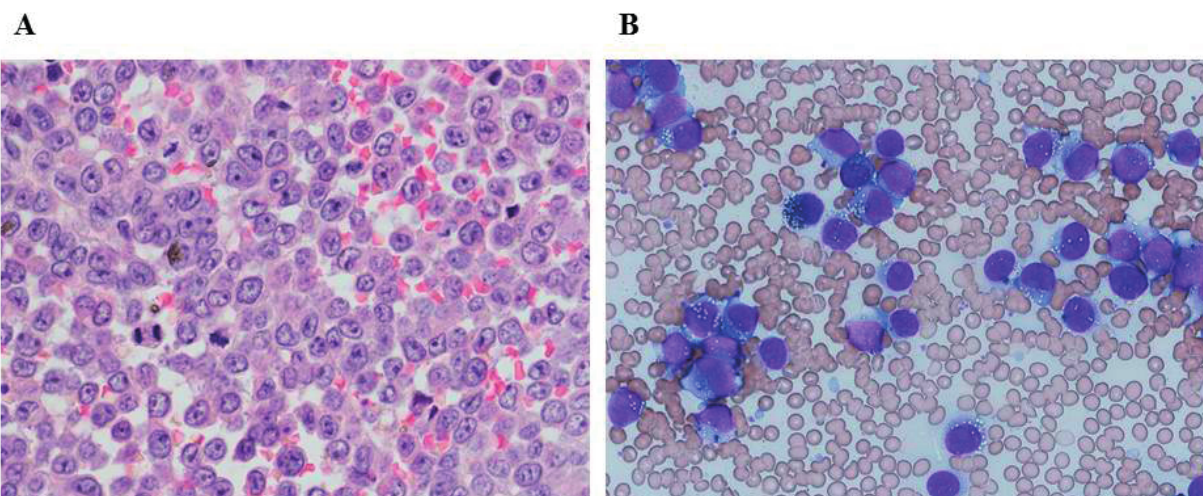
Fig. 3. morphology of the bone marrow. (a) Trephine biopsy (magnification 400x, hematoxylin-eosin staining) and (B) bone marrow aspirate (magnification 400x, may-Grünwald-Giemsa staining) show diffuse infiltration with amelanotic cells with large nuclei, prominent nucleoli and vacuoles in the cytoplasm.